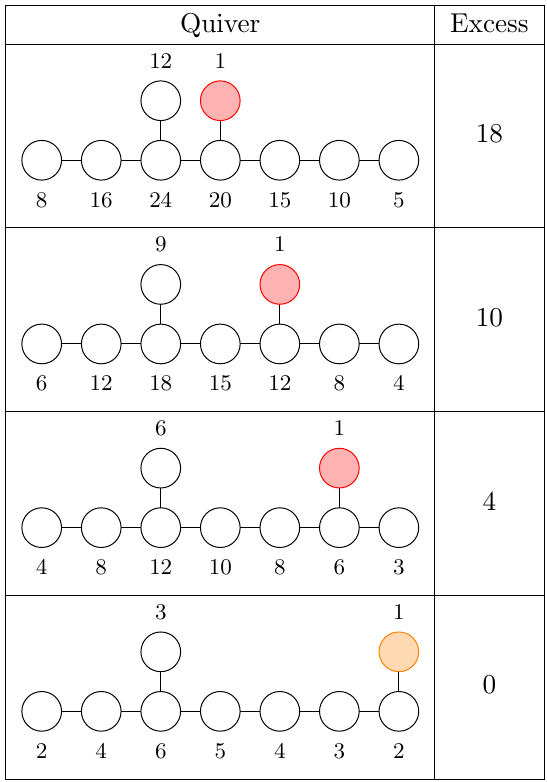
Table 7 . Second set of minimally unbalanced quivers with G = E 8